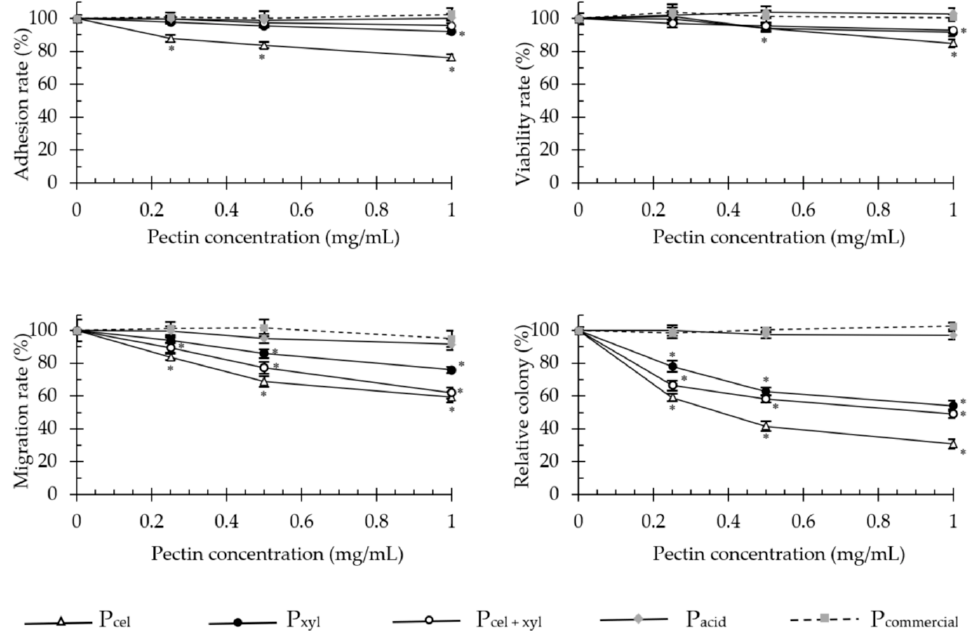
Figure 3. The effect of apple pectins on B16F10 cell proliferation, migration, adhesion and growth in soft agar in vitro. The values represent the means ± SD of cells/colonies (% control). All the experiments were performed thrice in triplicate. * p ˂ 0.001 vs. the control group (Tukey test). P cel —cellulase-extracted pectin; P xyl —xylanase-extracted pectin; P cel + xyl —pectin extracted with both cellulase and xylanase; P commercial —commercial apple pectin. Both studied cell lines have been shown to overexpress β -galactoside binding protein (gal-3) [35,36]. Gal-3 is involved in tumor development, mainly through: (i) facilitation